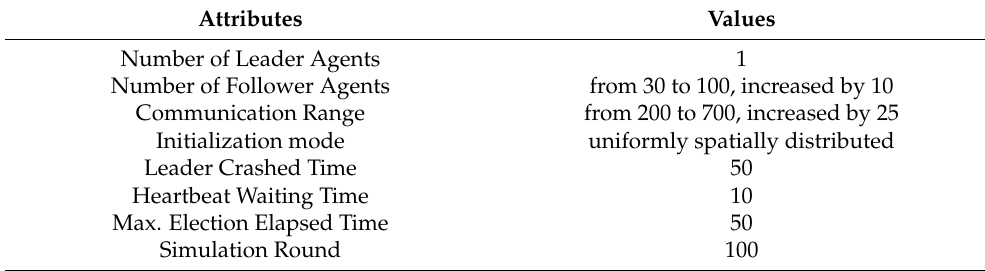
Table 1. Experiment Settings. Attributes Values Number of Leader Agents 1 Number of Follower Agents from 30 to 100, increased by 10 Communication Range from 200 to 700, increased by 25 Initialization mode uniformly spatially distributed Leader Crashed Time 50 Heartbeat Waiting Time 10 Max. Election Elapsed Time 50 Simulation Round